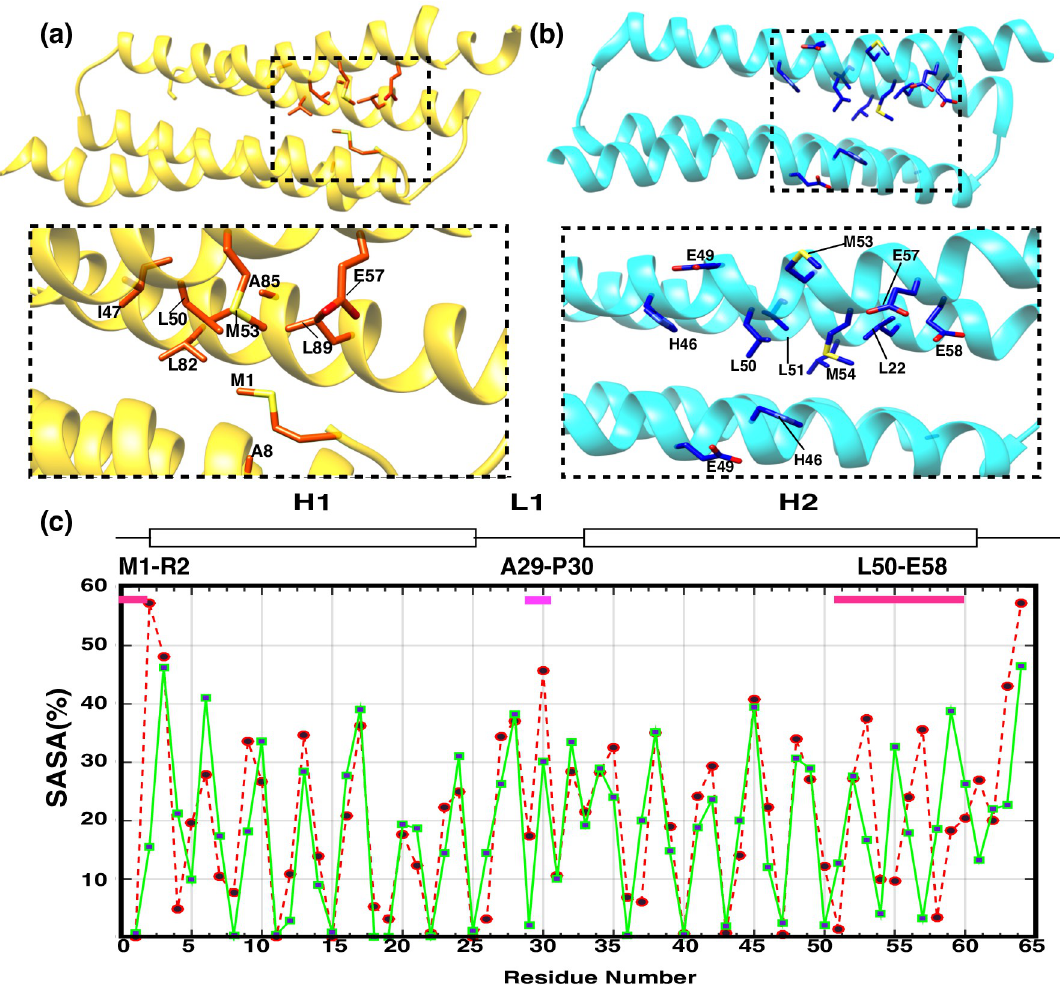
Fig 4. Differences between solution and crystal structures. (a)–(b) The hydrophobic-core composition of (a) solution and (b) crystal structures with residues having significant differences being tagged. (c) Relative solvent-accessible surface area (SASA) as a function of residue number (x-axis); each residue SASA value is represented as a black dot; green continuous line belongs to the SASA values of the crystal structure, while dotted red line represents solution-structure SASA